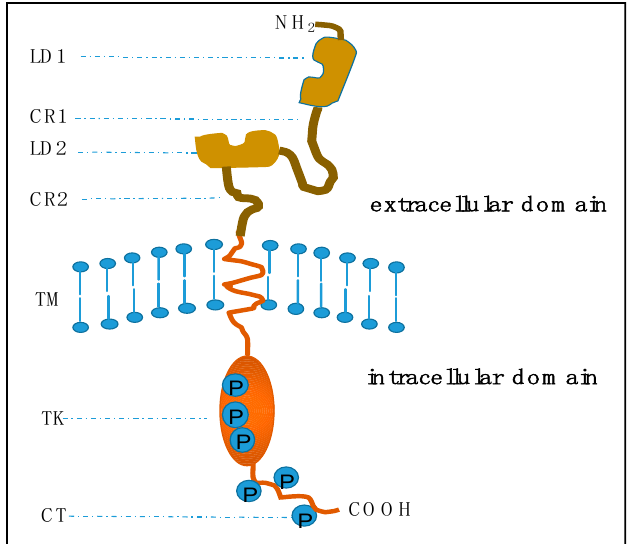
Figure 1. Basic structure of epidermal growth factor receptor (EGFR) transmembrane proteins. In the extracellular domain, LD1 and LD2 are two repeated ligand binding domains. CR1 and CR2 are two repeated cysteine rich regions. TM indicates the short transmembrane spanning sequences. In the intracellular domain, TK is a catalytic tyrosine kinase, and CT is the carboxyl-terminal tail. Circled Ps are the phosphorylation sites within the TK and CT regions. This figure is revised based on the review of the oncogene human epidermal growth factor 2 ( HER2 ) contributed by Moasser [17].